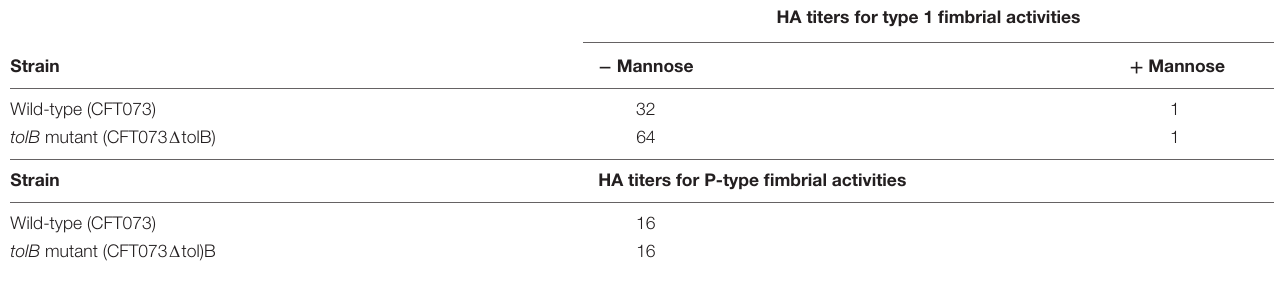
TABLE 3 | HA titers of the wild-type parent and the tolB